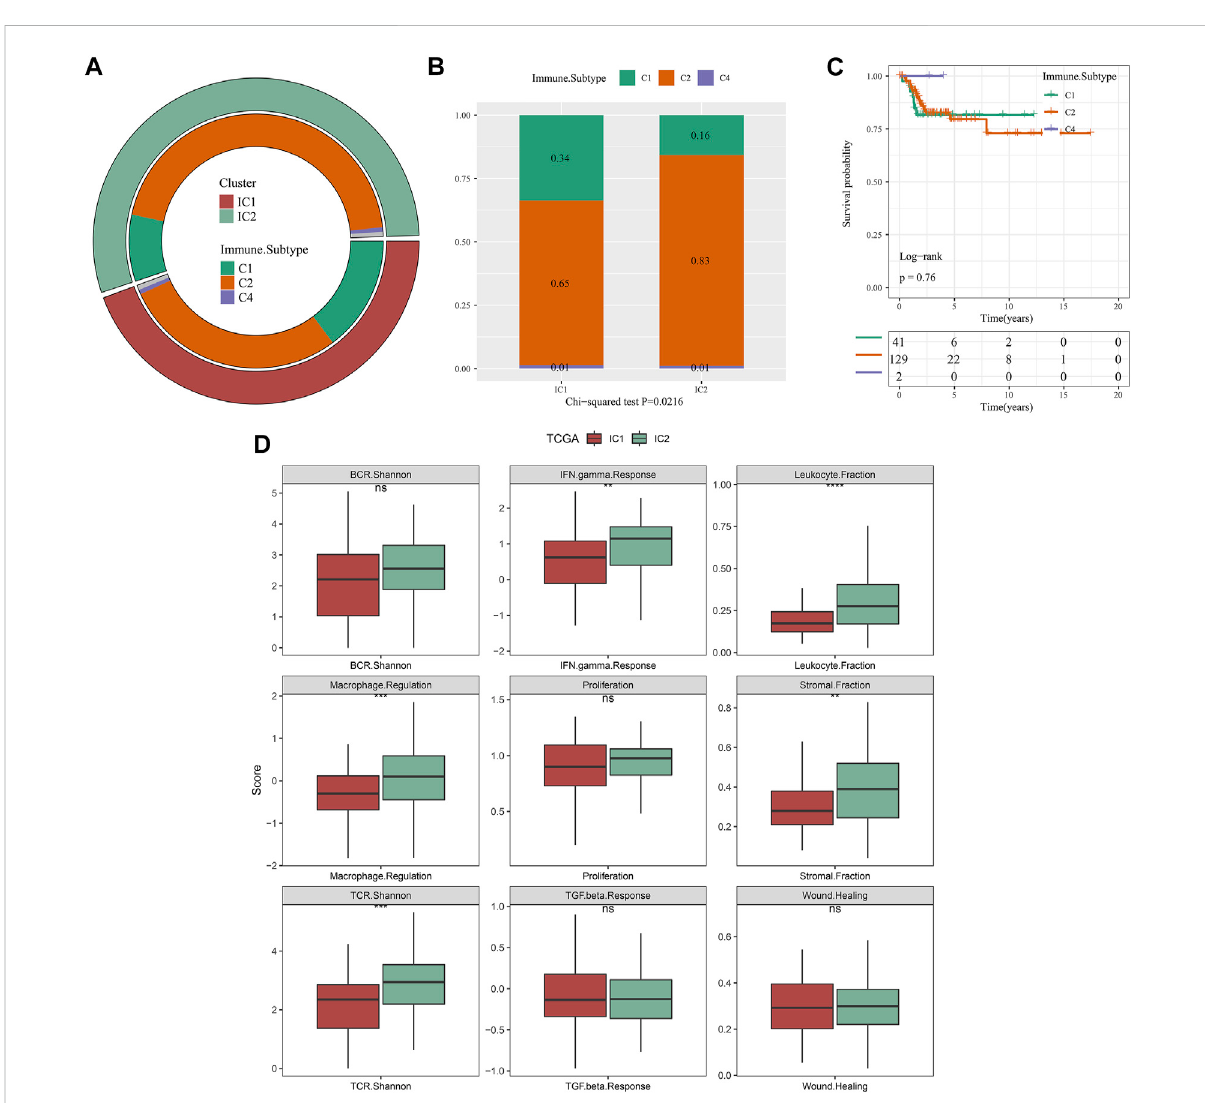
FIGURE 5 Associations of our molecular classi fi cation with existing immune subtypes in the TCGA dataset. (A) The distribution of existing immune subtypes (C1, C2 and C4) across our molecular classi fi cation. (B) Comparison of proportion of existing immune subtypes between IC1